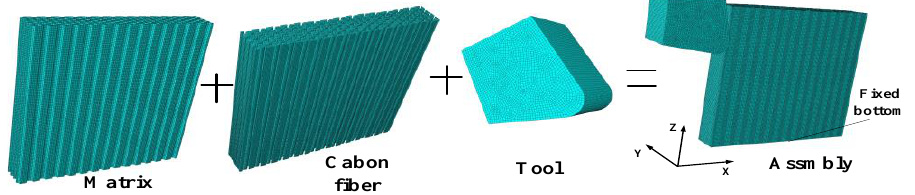
Figure 3. Finite element mesh.